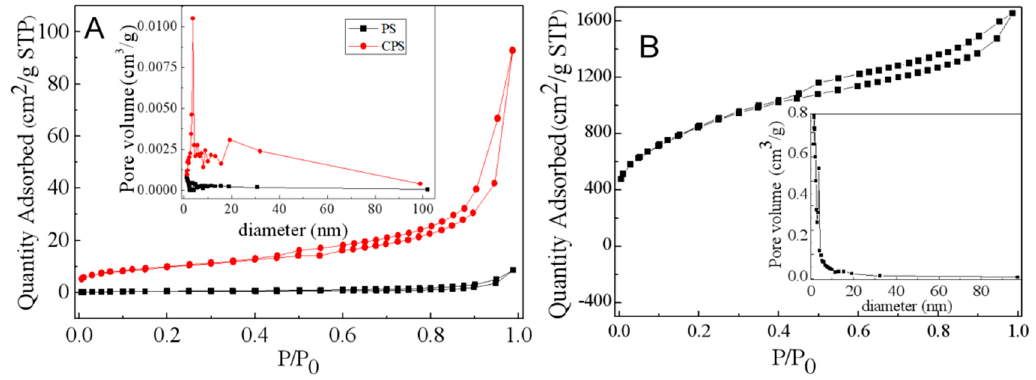
Figure 2. Nitrogen adsorption-desorption isotherm and pore size distribution of ( A ) PS and CPS; ( B ) K-Ac.